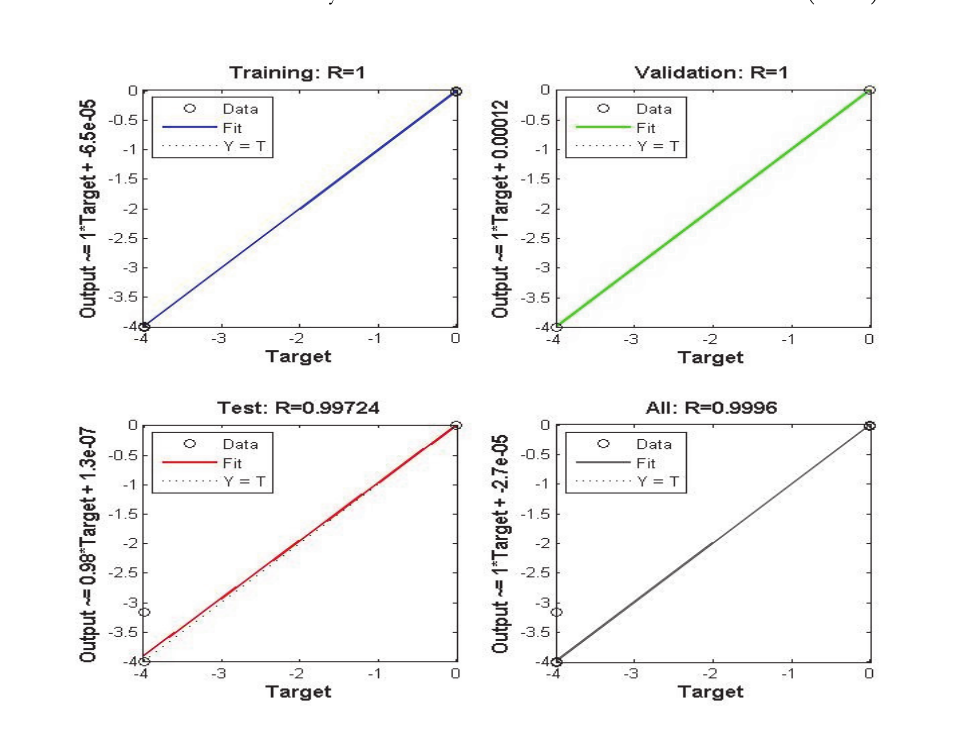
Figure 8: The correlation between the desired exit and the exit of the network.